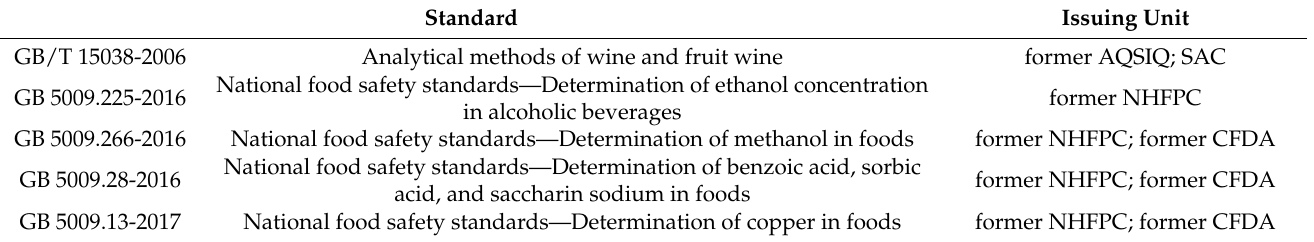
Table 3. National standards for analytical methods of sensory and physicochemical indicators of wine in China.